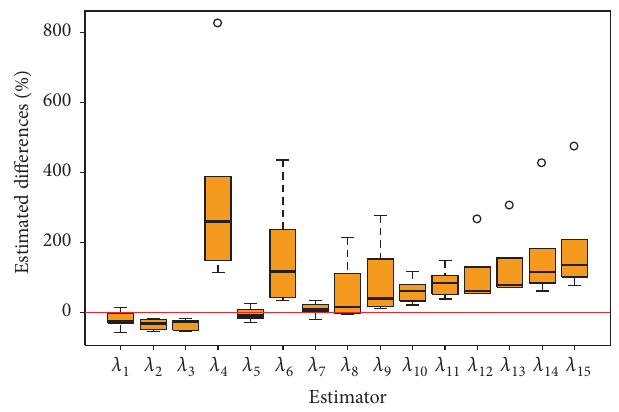
Figure 5: Box-plot representing the distribution of mean relative differences in tree density estimation, between each estimator and the quadrat counts, based on the data from the six Pittosporum undulatum plots.